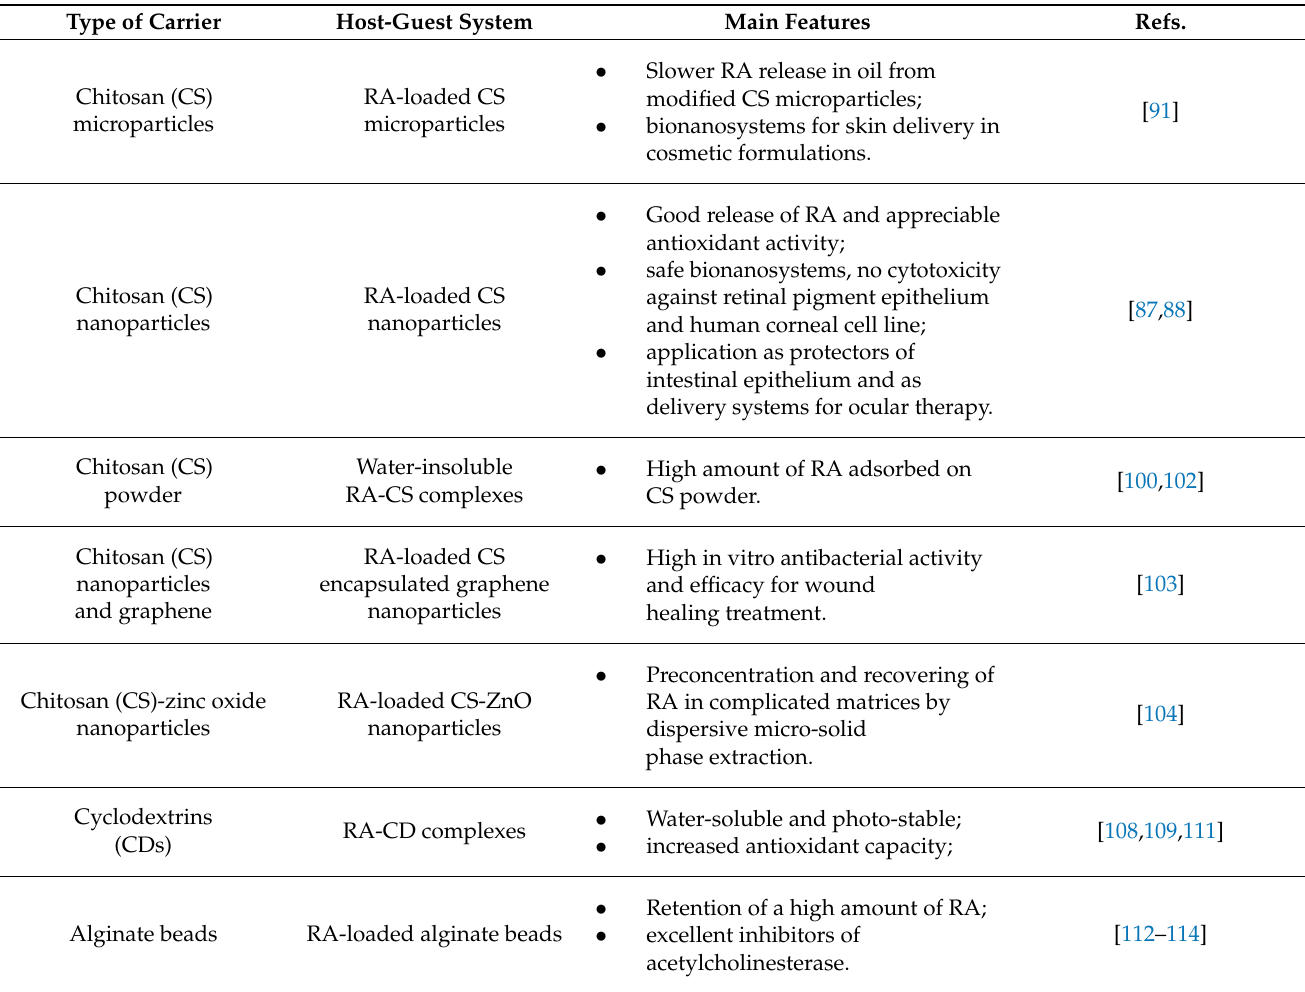
Table 1. Encapsulation of RA in in organic nano and microsystems. Main